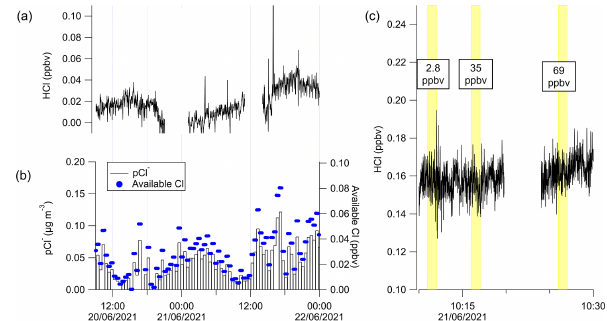
Figure 10. Time series of (a) HCl when the denuder was installed on HCl TILDAS inlet in comparison with (b) pCl − observations. Available Cl was calculated by converting the pCl − concentrations into mixing ratios. (c) HCl cylinder additions were conducted (yel- low shading) to verify the denuder was removing gas-phase HCl. The data in panel (c) have not been blank corrected or time aver- aged.